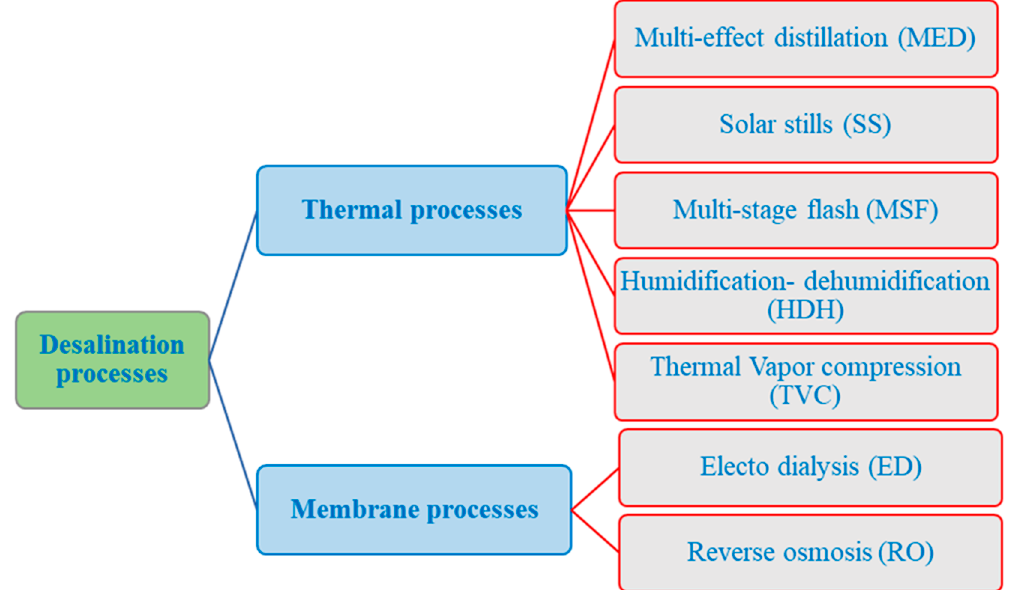
Figure 1. Common water desalination processes.